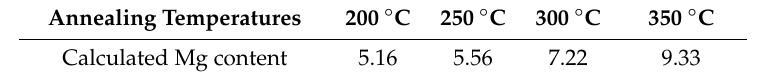
Figure 1. X-ray di ff raction (XRD) pattern of Al–10Mg alloy at di ff erent states; ( b ) is local amplification of ( a ). Table 2. Chemical composition (wt %) of Mg atom solute in matrix.